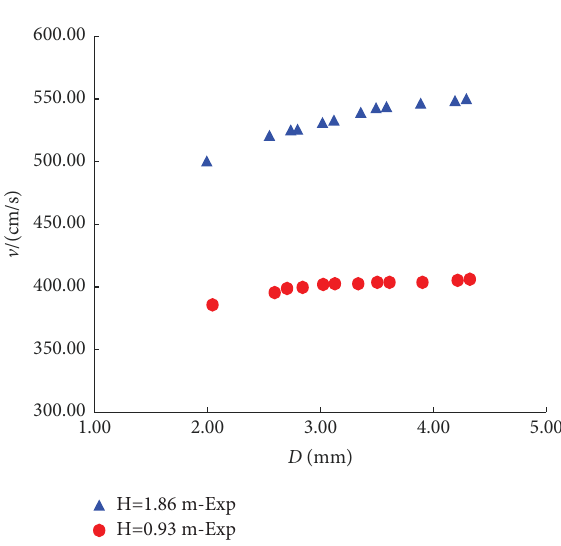
Figure 21: Comparison graph of raindrop end velocity.